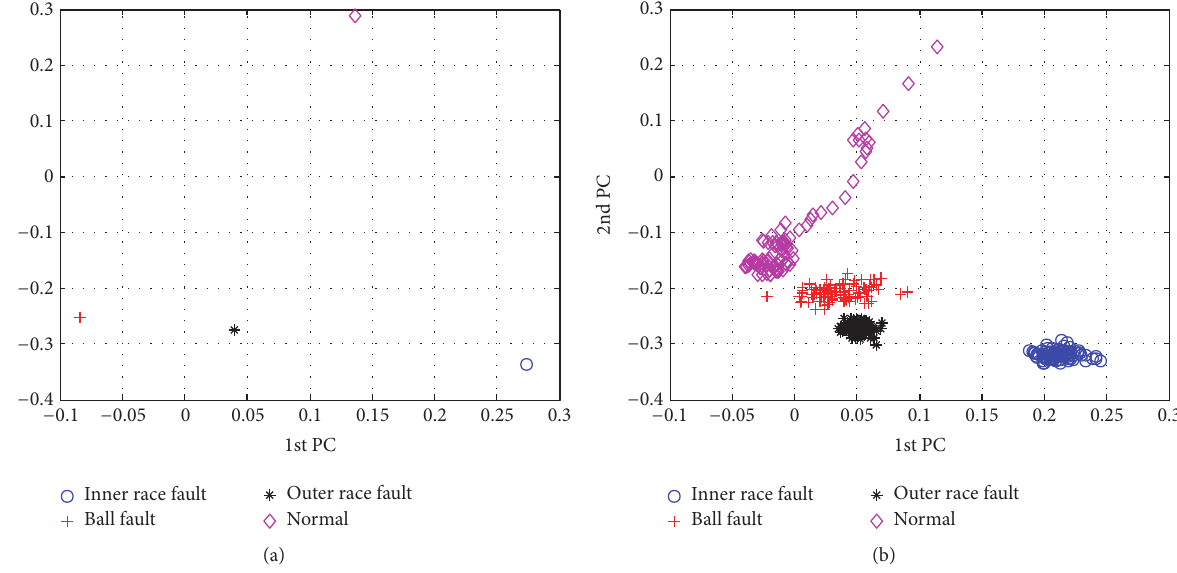
Figure 7: Feature extraction with SKLPP: (a) training set and (b) testing